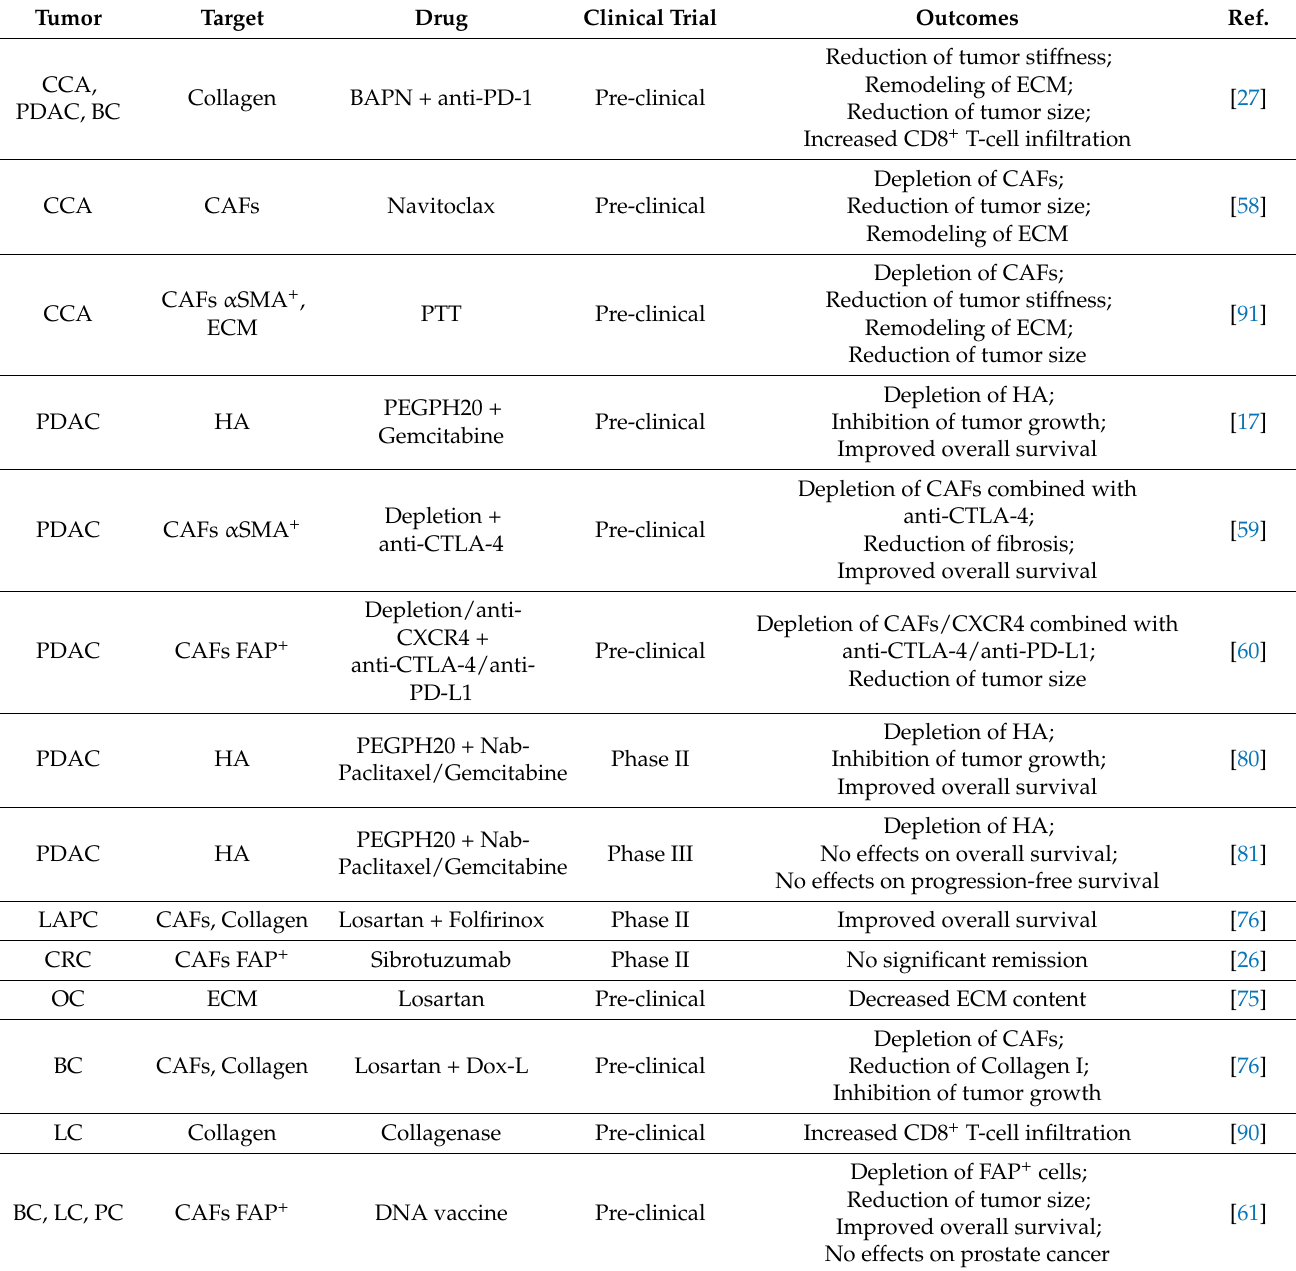
Table 2. Summary of ECM/CAFs pre-clinical and clinical trials in different